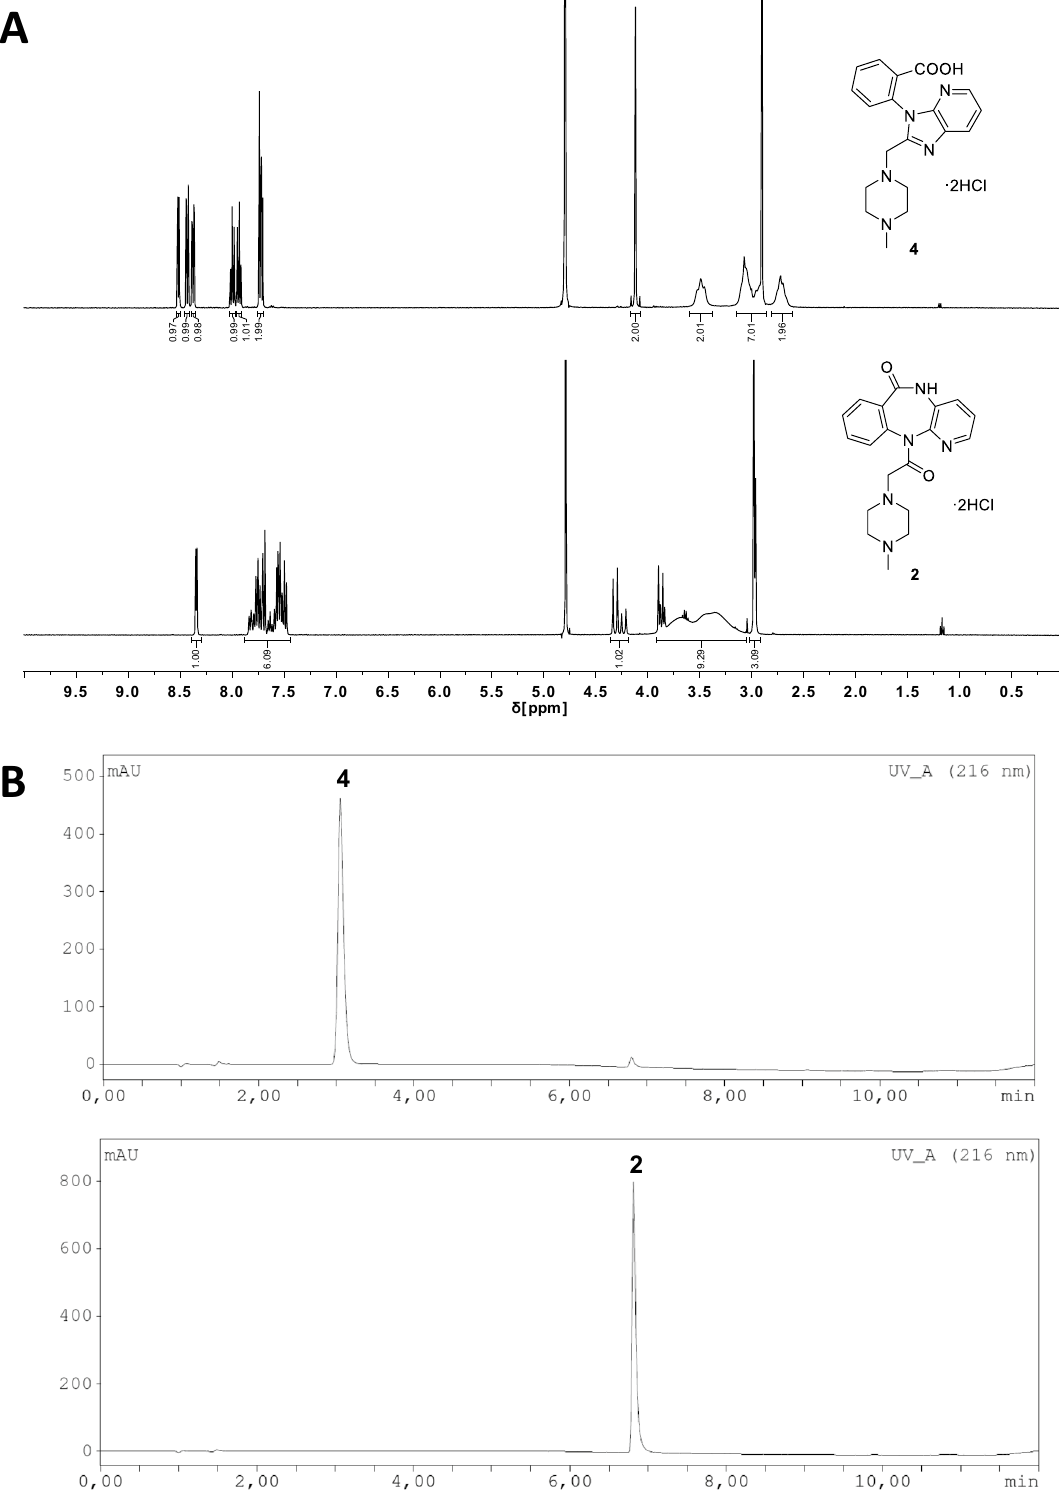
Figure 3. A: 1 H-NMR spectra of 4 (top, sample #2) and 2 (bottom, sample #4) in D 2 O at 400 MHz. B: UV-HPLC traces of 4 (top, sample #2) and 2 (bottom, sample